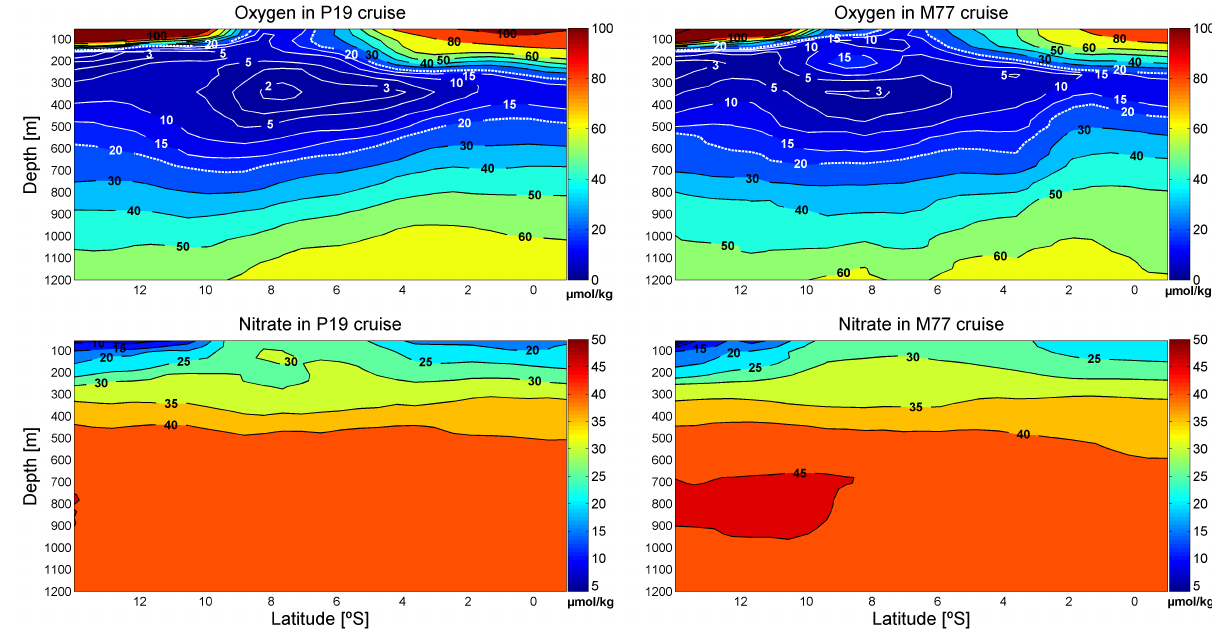
Fig. 7. Meridional section with measured oxygen (µmolkg − 1 ) and nitrate (µmolkg − 1 ) for the P19 (March 1993) and the M77 (February 2009) cruises.